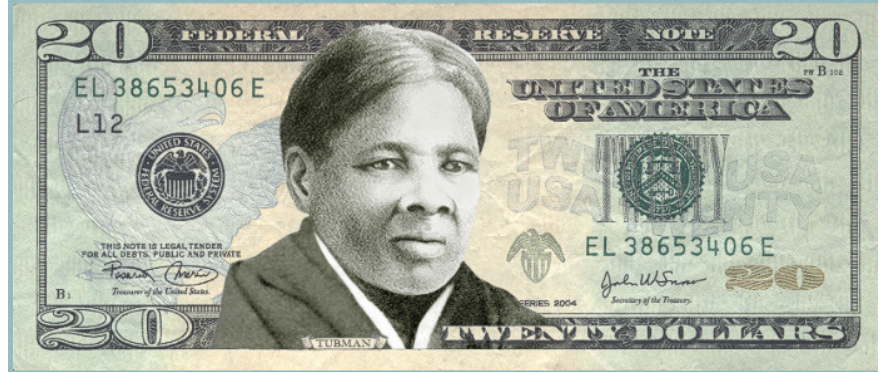
Figure 1. One of the proposed designs for the twenty-dollar bill featuring Harriet Tubman on the front. Initially, the administration had opted for redoing the ten-dollar note, but Alexander Hamilton, who was accordingly scheduled for the move, regained popularity as a result of the eponymous Broadway show. So, in accordance with Women on 20s’ demand, it would be up to Jackson to leave the monetary front